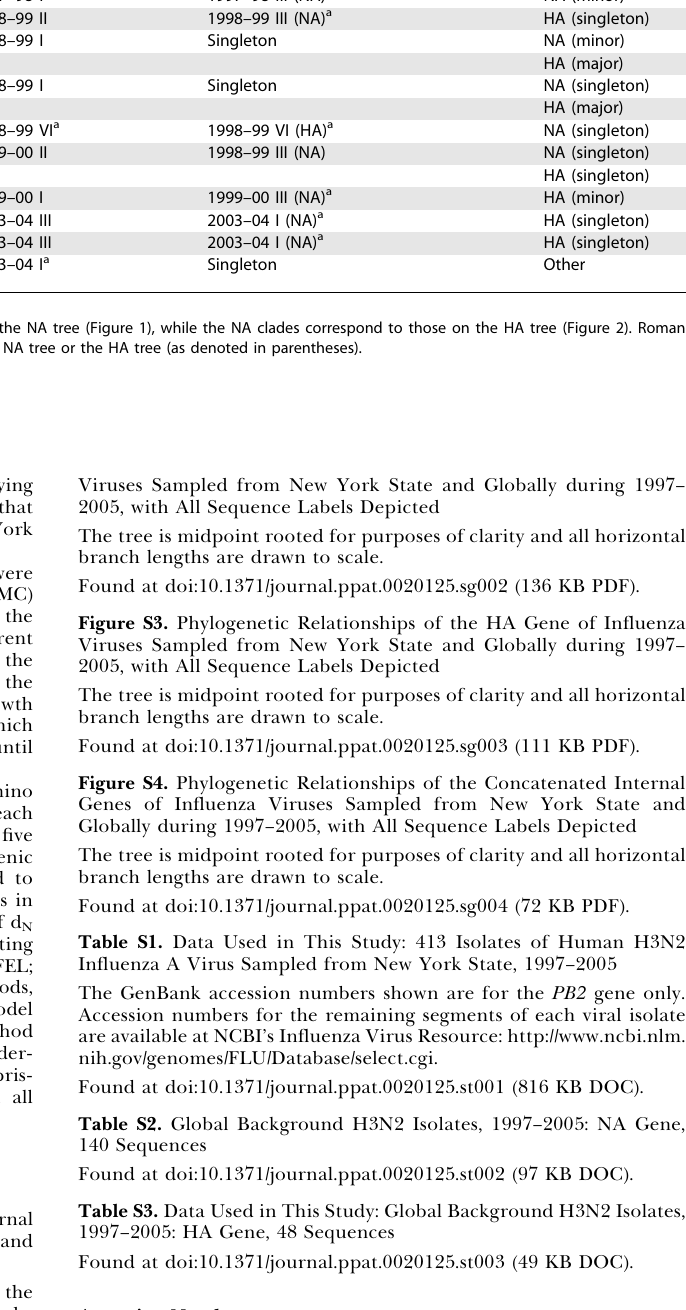
Table 3. Reassortment Events in H3N2 Influenza A Virus from New York State,